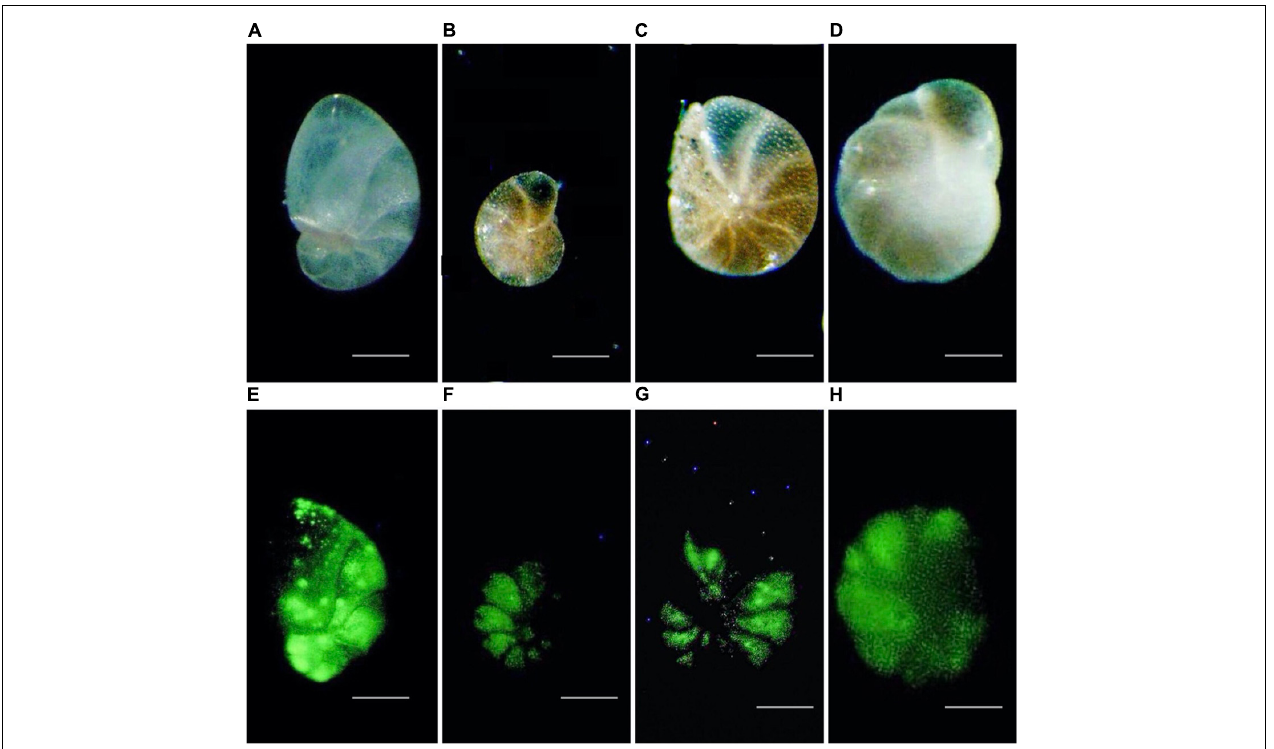
FIGURE 6 | Reflected light (A–D) and corresponding epifluorescence (green coloration from CellTracker TM Green) (E–H) micrographs of foraminifera collected at Vestnesa Ridge (core 893A); (A,E) Nonionellina labradorica ; (B,C,G,F) Melonis barleeanus ; (D,H) Cassidulina neoteretis . Scales: panels (A–D) = 30 µ m; panels (B,C,F,G) = 25 µ